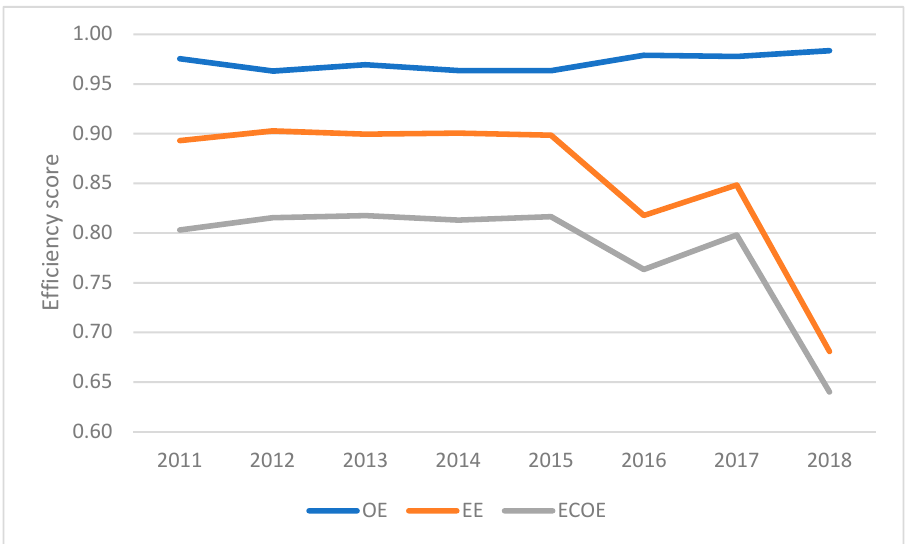
Figure 1. Evolution of average operational efficiency (OE), environmental efficiency (EE) and eco- efficiency (ECOE) of English and Welsh water companies.